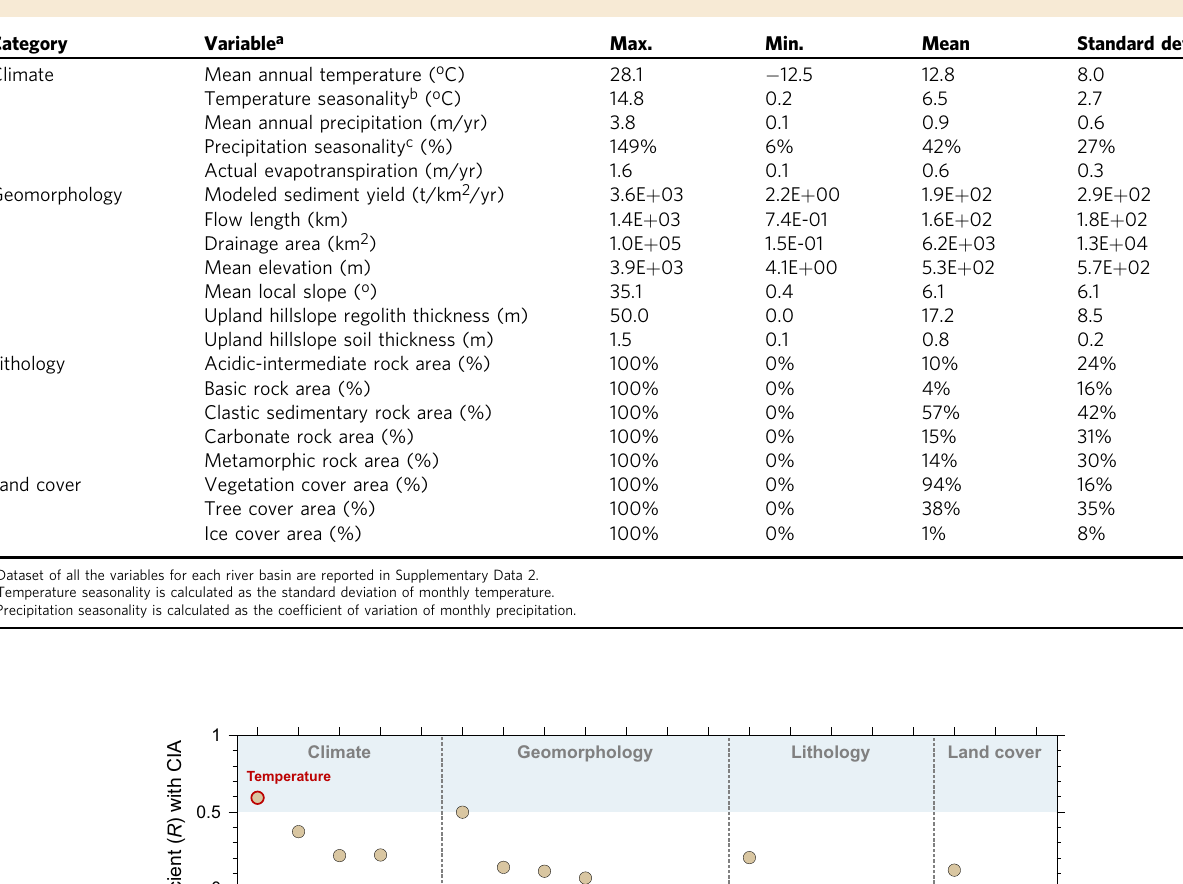
Table 1 Range of each environmental control variable in the compiled dataset.